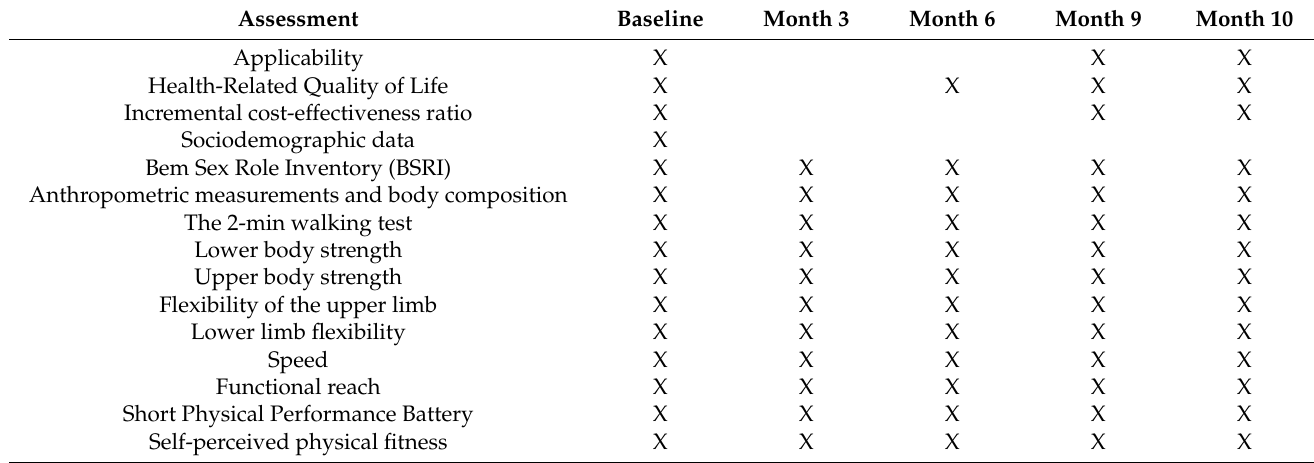
Table 2. Assessments scheduled for both experimental and control